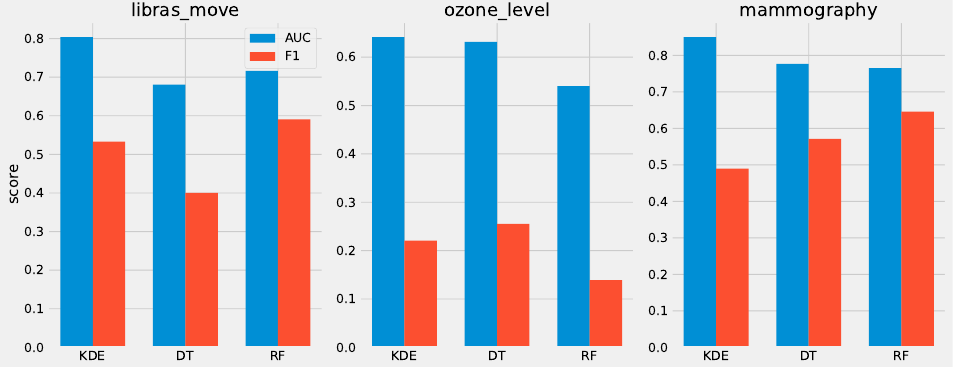
Figure 6. Classifier performances as measured by AUC and the F 1 -score.